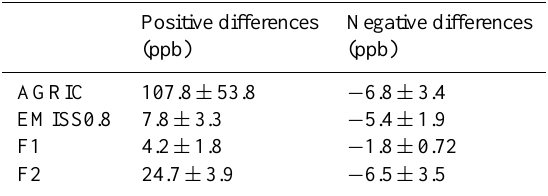
Table 3. Maximum positive and negative O 3 differences between the sensitivity runs and the reference